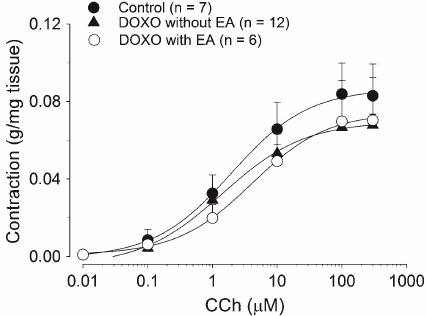
Figure 3. Comparison on the effect of carbachol (CCh) on the gastric fundic strips of fetus with EA. The graph shows the mean tension of the gastric fundic strips in response to increasing concentrations of CCh (0.01-300 m M). The tension was verified considering difference in peak and the amplitude expressed as g (force)/mg (tissue mass). Data are reported as means±SE. DOXO: doxorubicin. There were no statistical differences in contractile activity in response to CCh comparing treated groups to controls (P . 0.05, two-way ANOVA, followed by a Student- Newman-Keuls test).